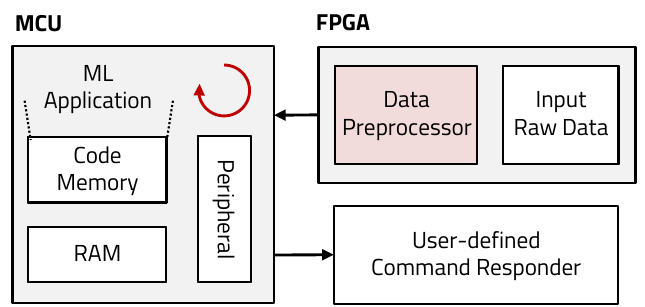
Figure 1. Proposed architecture overview for a custom hardware preprocessor coupled with a machine learning (ML)